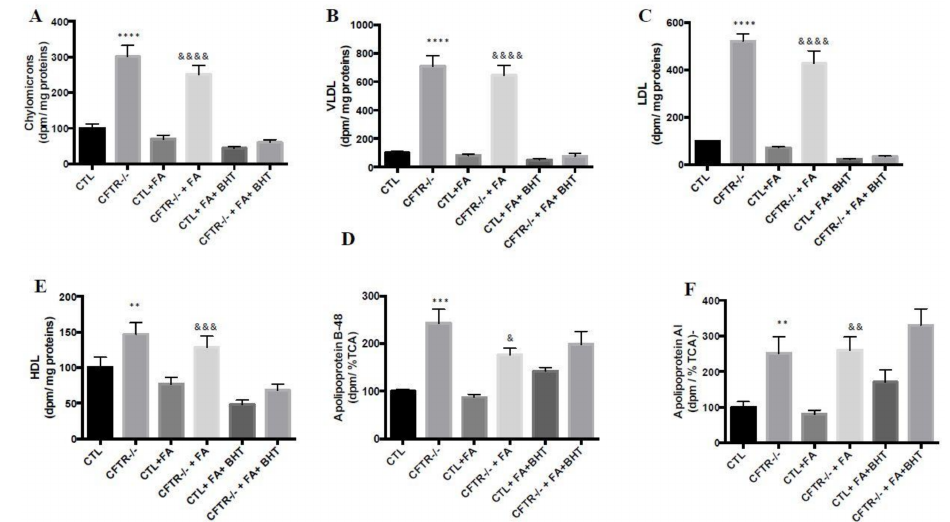
Figure 8. Influence of CFTR deletion on lipoprotein production and on de novo apolipoprotein synthesis in Caco-2/15 cells. Caco-2/15 cells were allowed to differentiate until 15 days after confluence. Then, cells were challenged with ( 14 C)-oleic acid. Lipoproteins production was assessed by quantification of ( A ) chylomicrons, ( B ) very low-density lipoproteins, ( C ) low-density lipoproteins, and ( D ) high-density lipoproteins in basolateral medium. Caco-2/15 cells were challenged with ( 35 S)-methionine and de novo apolipoproteins (apo) synthesis was assessed in cell lysate by the measurement of apos ( E ) B-48 and ( F ) A-I. Values are means ± SEM of 3 independent experiments, each performed in triplicate. ** p < 0.01, *** p < 0.001, **** p < 0.0001 vs. CTL cells; & p < 0.05, && p < 0.01, &&& p < 0.001, &&&& p < 0.0001 vs. CTL + FA cells. CTR. control cells; FA: iron/ascorbate (200 µ M/0.5 mM); BHT: Butylated hydroxy toluene (0.5